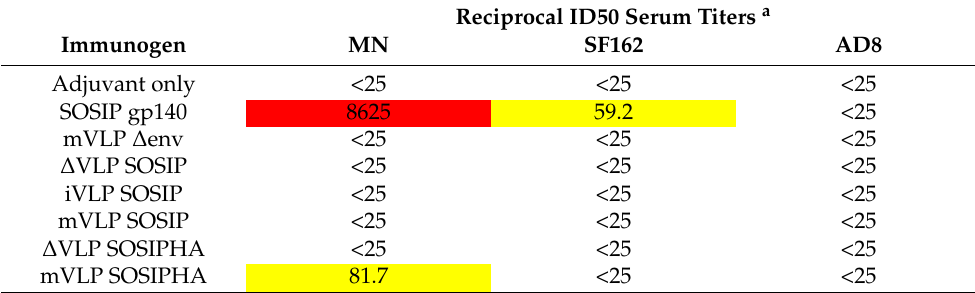
Table 4. Reciprocal ID50 serum neutralization